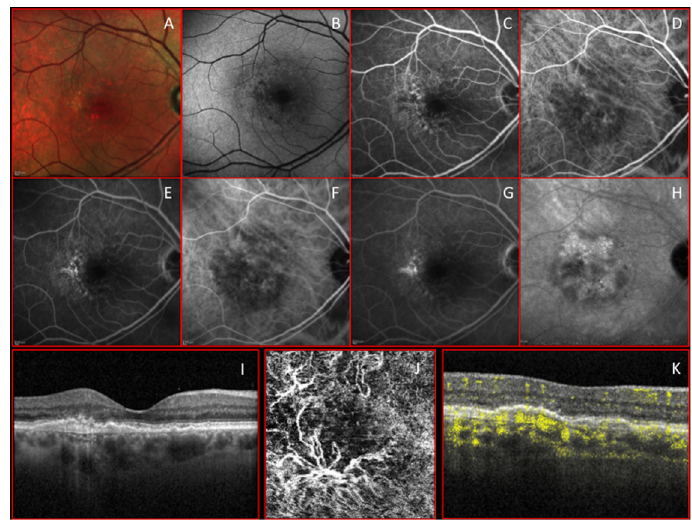
Figure 1. Multimodal imaging clearly shows a treated type 1 macular neovascularization (MNV). ( A , B ) Color and autofluorescence images; ( C – E ) early, middle, and late phase of fluorescein angiography. ( F – H ) Early, middle, and late stage of indocyanine green. ( I – K ) 3 mm × 3 mm optical coherence tomography angiography (OCTA) and co-registered structural optical coherence tomography (OCT) scan show that a florid arborization of vessels is evident at the outer retina slab with a high choroidal flow void signal under the subretinal pigmentary epithelium (RPE) in correspondence with the macular neovascularization (MNV) lesion.